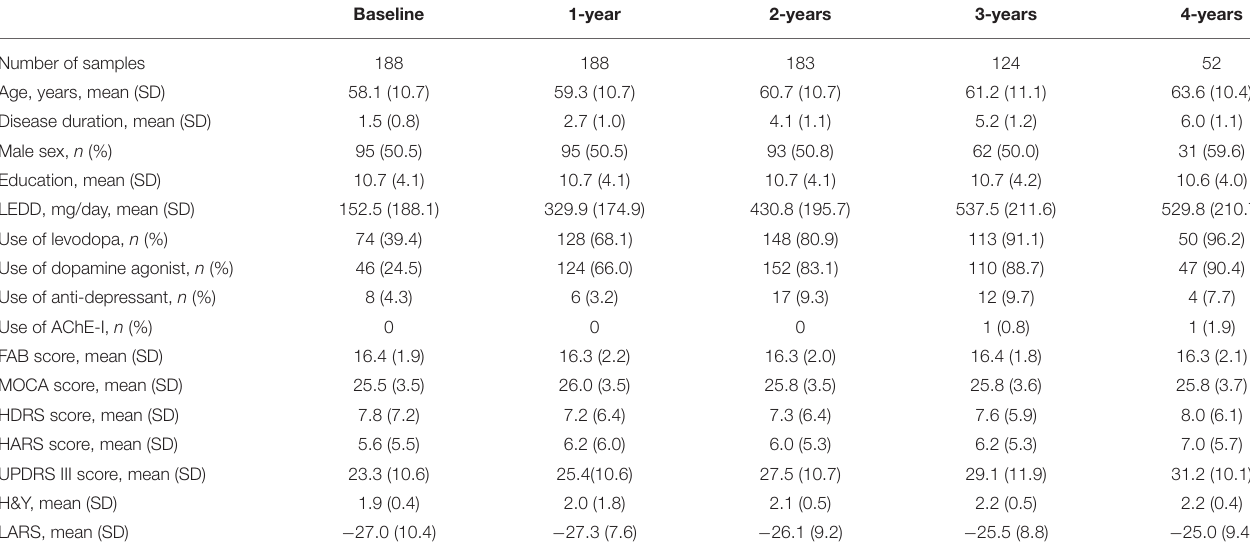
TABLE 1 | Demographic and clinical features of PD